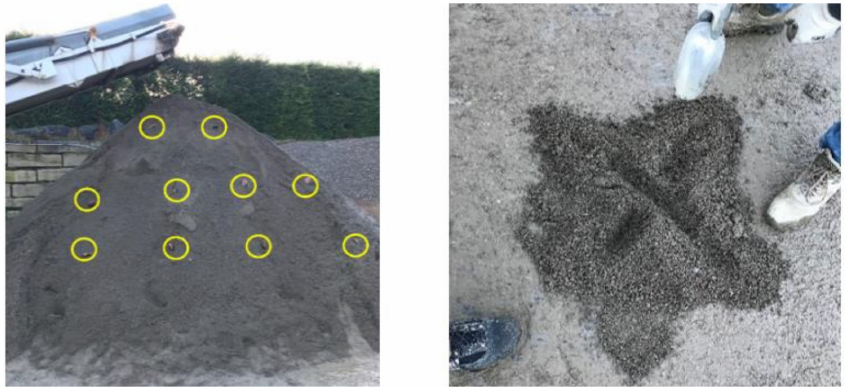
Figure 2. RA sampling points and quartering